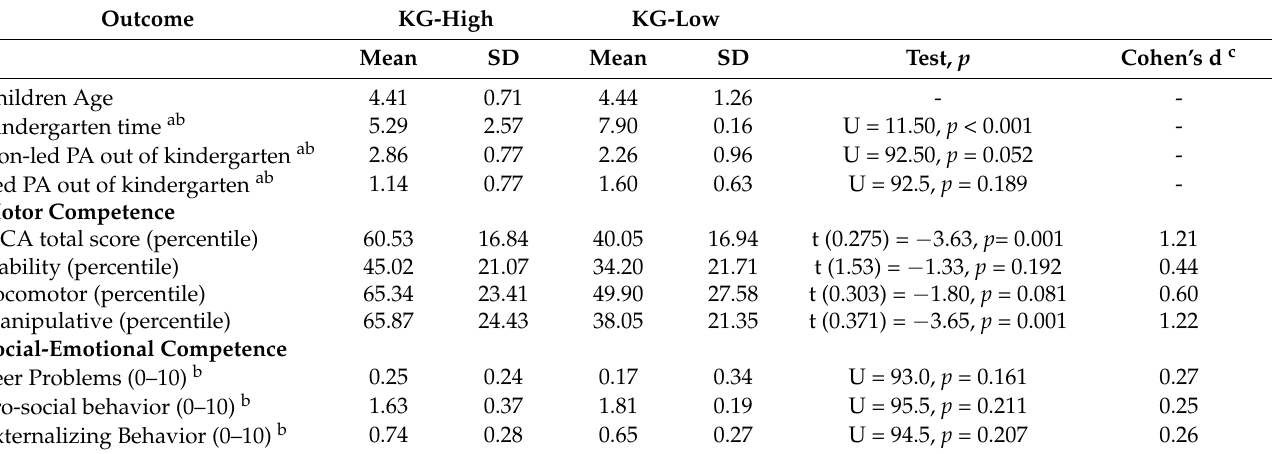
Table 3. Differences between KG-high (n = 17) and KG-low (n = 19) for children age, hours spent in kindergarten, hours in non-adult and adult led PA out of the kindergarten, and motor- and social-emotional competence